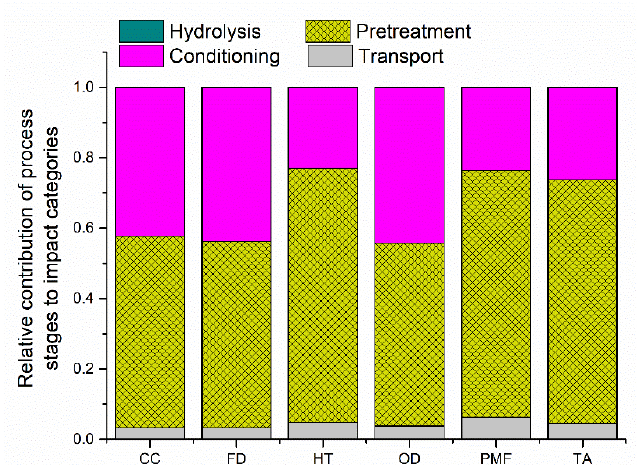
Figure 6. LCA results obtained for the relative contribution of process stages to the evaluated impact categories in glucose production from woody biomass residues.